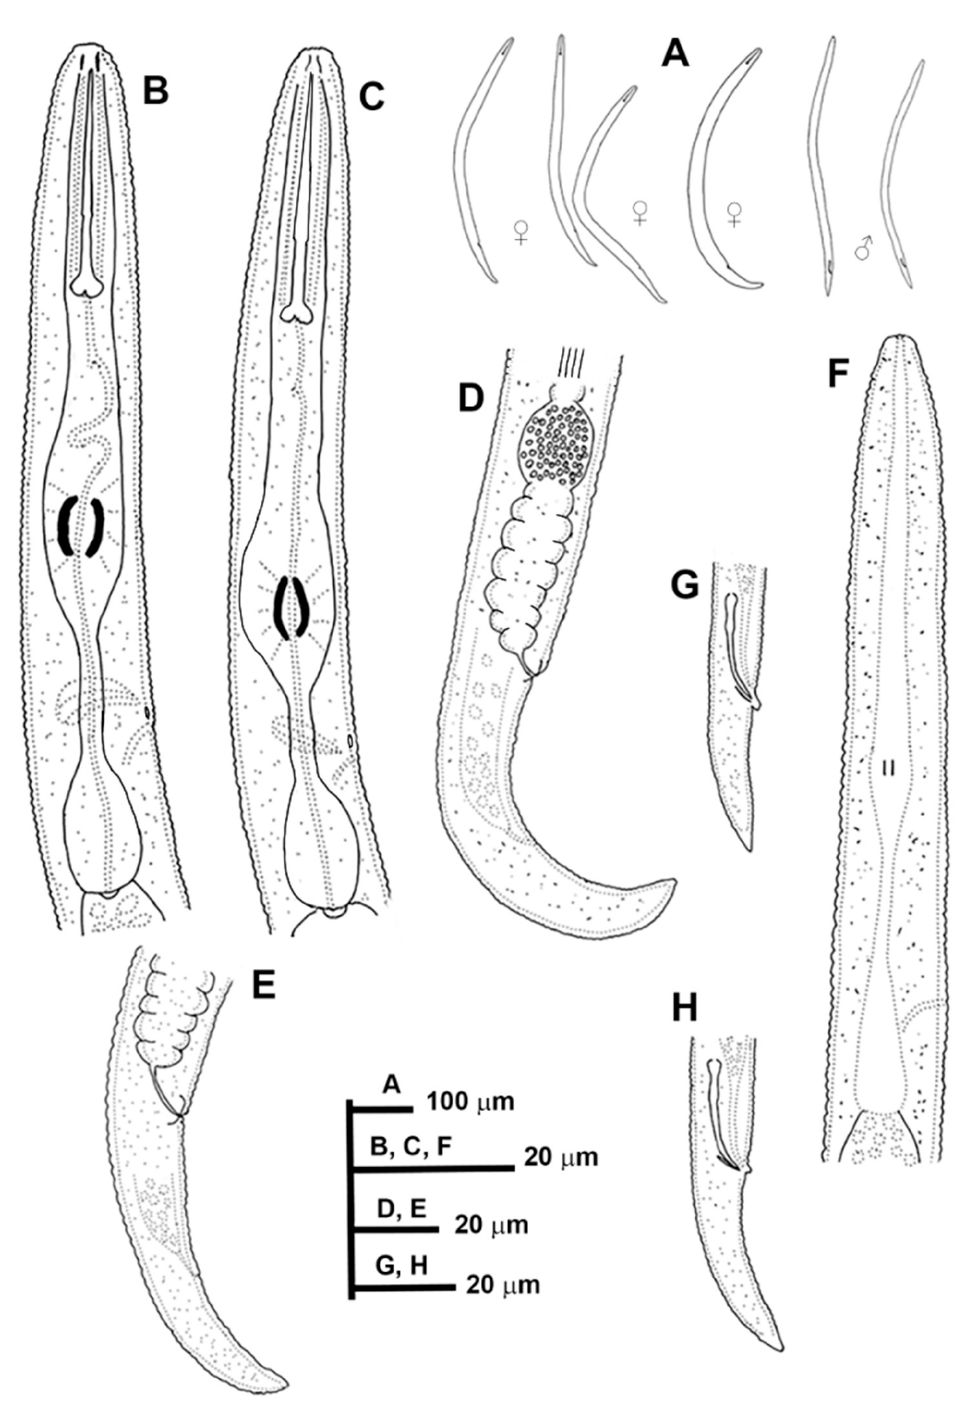
Figure 1. Line drawings of Paratylenchus caravaquenus sp. nov. ( A ): Entire females and males; ( B , C ): Female pharyngeal region; ( D , E ): Female posterior region; ( F ): Male pharyngeal region showing absence of stylet; ( G , H ): Male posterior region.